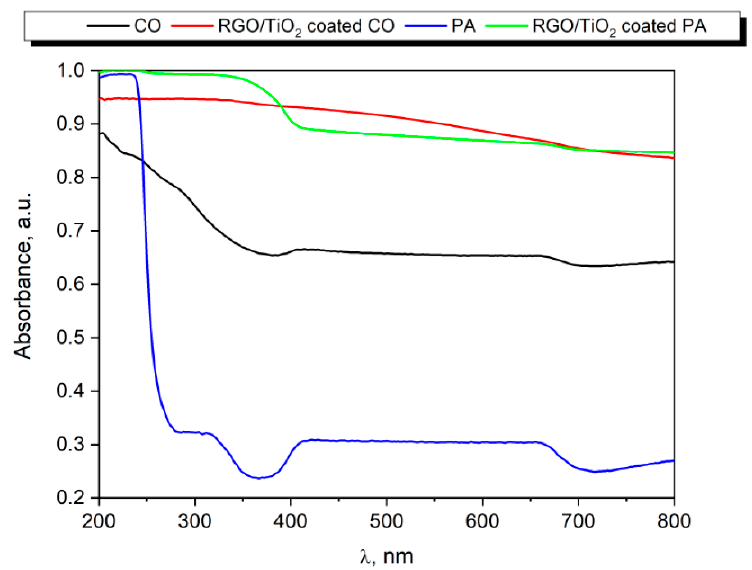
/ TiO 2 coated fabrics.